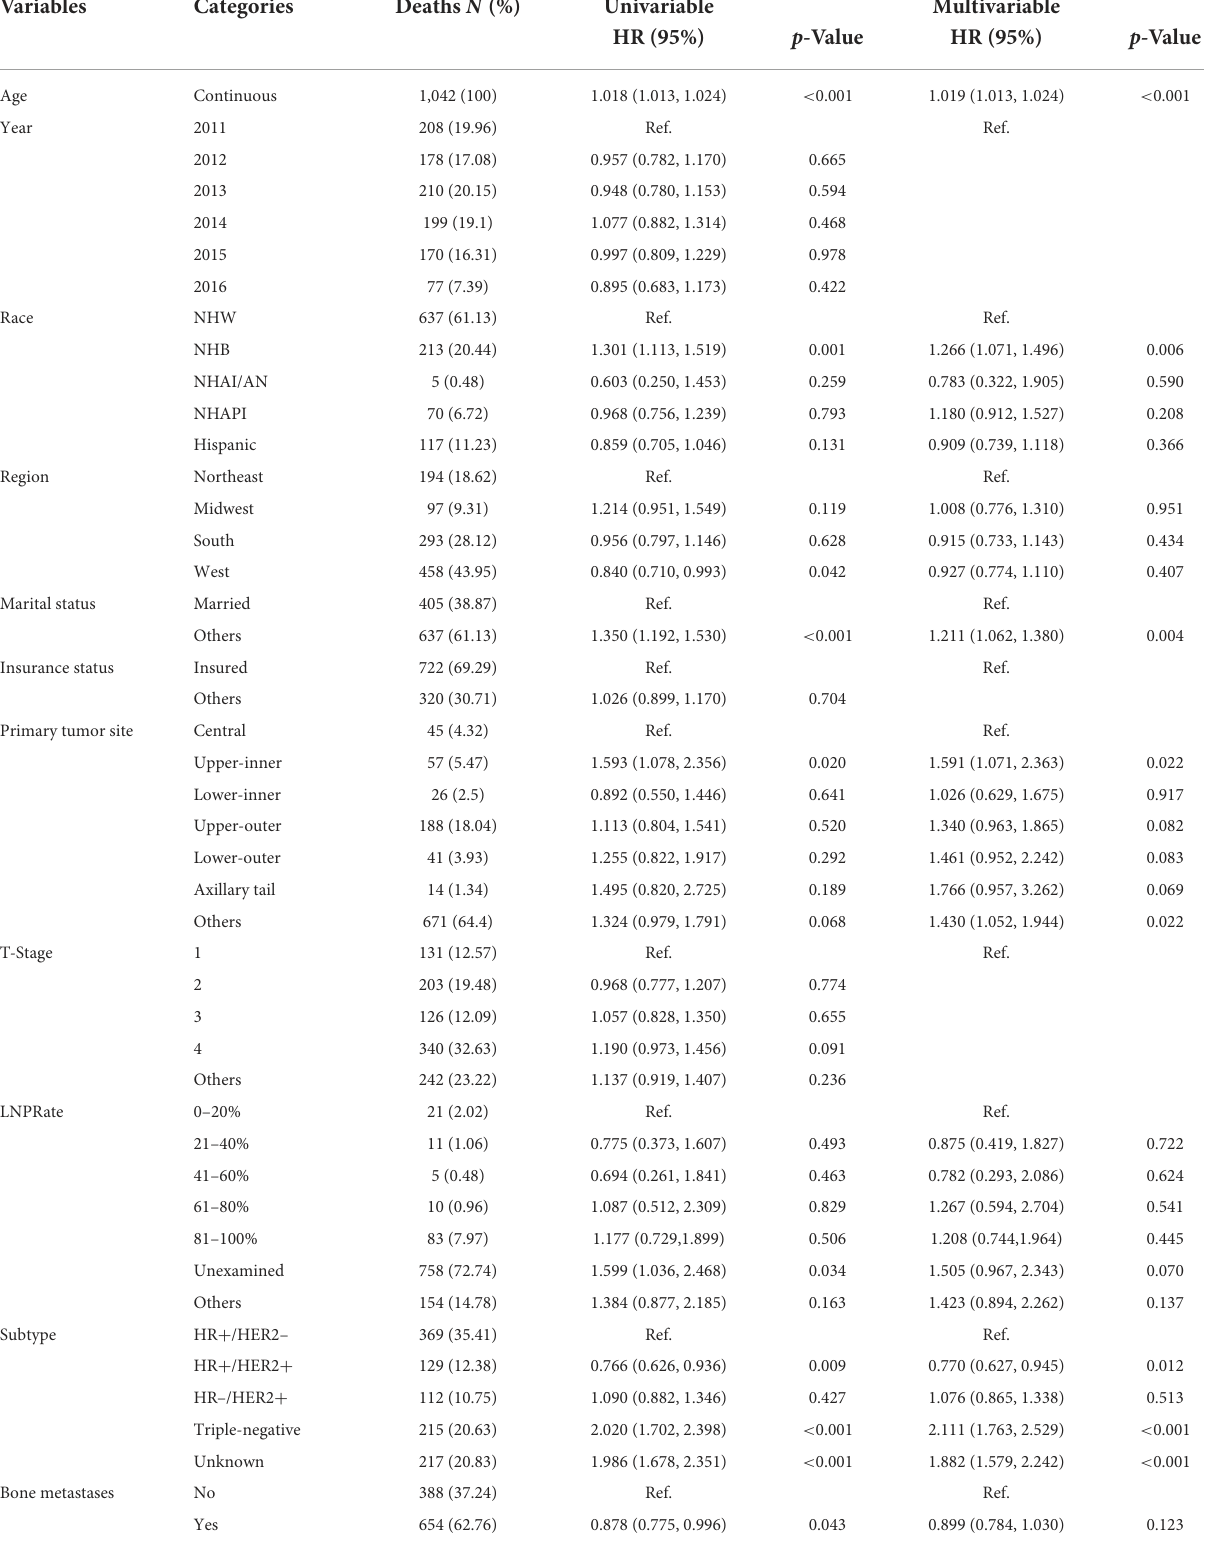
TABLE 3 Distribution of breast cancer synchronous brain metastases all-cause mortality and hazard risk associated with various prognostic